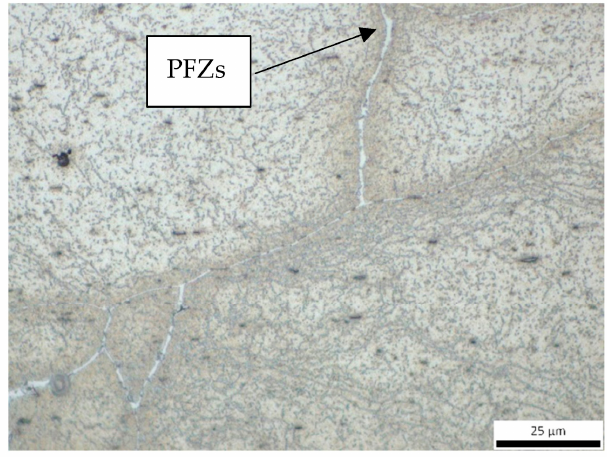
Figure 3. Continuous network of grain boundary PFZs in the AC sample (white color).